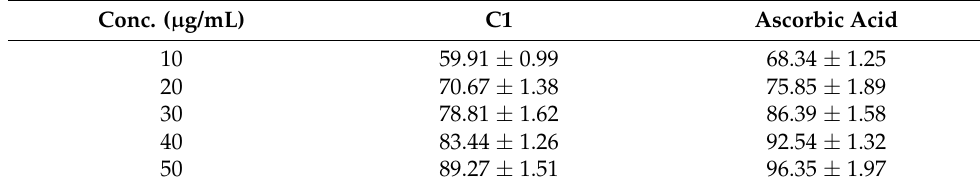
Table 10. O 2 − radicals scavenging capacity of Physcion.